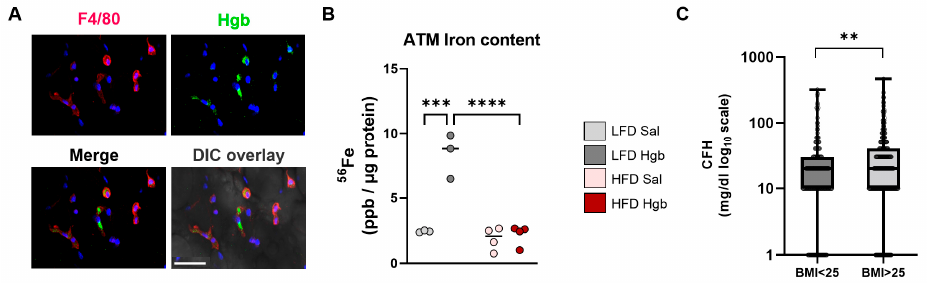
Figure 2. Hemoglobin is taken up by ATMs, and cell-free hemoglobin concentrations change with obesity . ( A ) Seven- to nine-week-old chow-fed male mice were injected IP with fluorescent hemoglobin, and adipose tissue slices from these mice were stained with F4/80 and DAPI (blue) and imaged. ( B ) Iron ( 56 Fe) content from adipose tissue macrophages (ATMs) isolated from mice fed a low-fat diet (LFD) or a high-fat diet (HFD) for 20 weeks and injected with saline (Sal) or hemoglobin (Hgb) at week 19 every other day for a total of 4 doses. ( C ) Plasma samples were collected from human adults of both sexes with varying BMIs and cell-free hemoglobin (CFH) levels measured by HemoCue. For panel B, two-way ANOVA with Bonferroni’s multiple comparison post-hoc tests were used ( n = 3). For Panel C, Wilcoxon rank sum test for CFH in humans ( n = 425) was used. ** p < 0.01, *** p < 0.001, **** p < 0.0001.